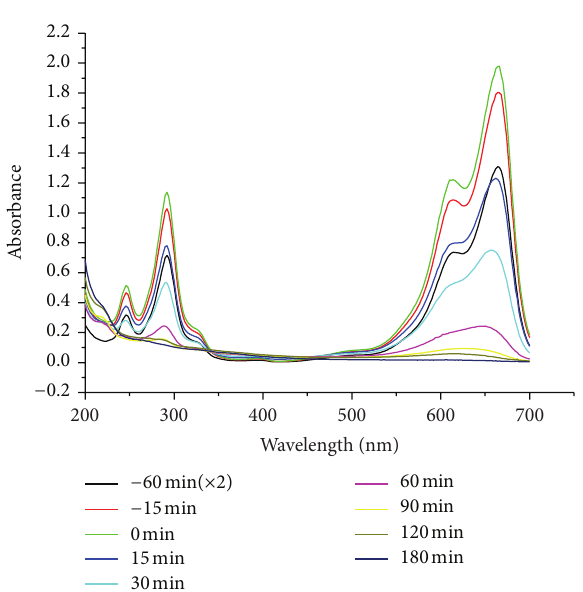
Figure 5: Typical time dependent UV-Vis absorption spectra of aqueous MB solution irradiated with UV light (280–420 nm) for different time intervals. The spectrum is obtained for sol-gel derived TiO 2 from titanyloxysulphate.